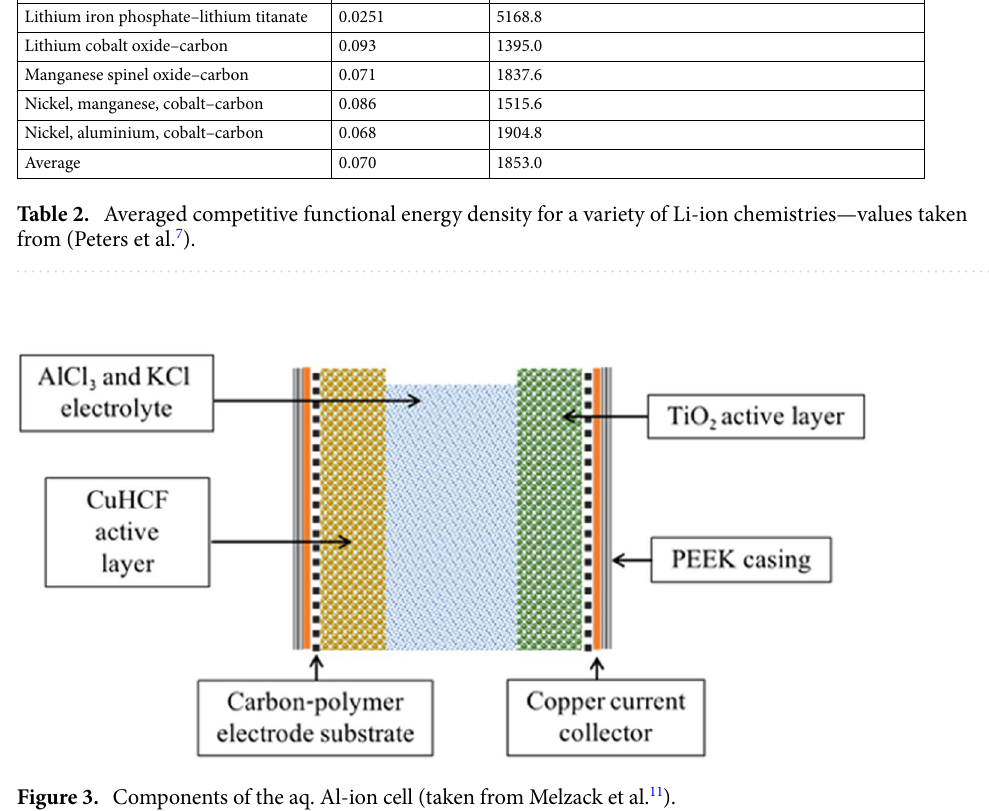
Figure 3. Components of the aq. Al-ion cell (taken from Melzack et al. 11